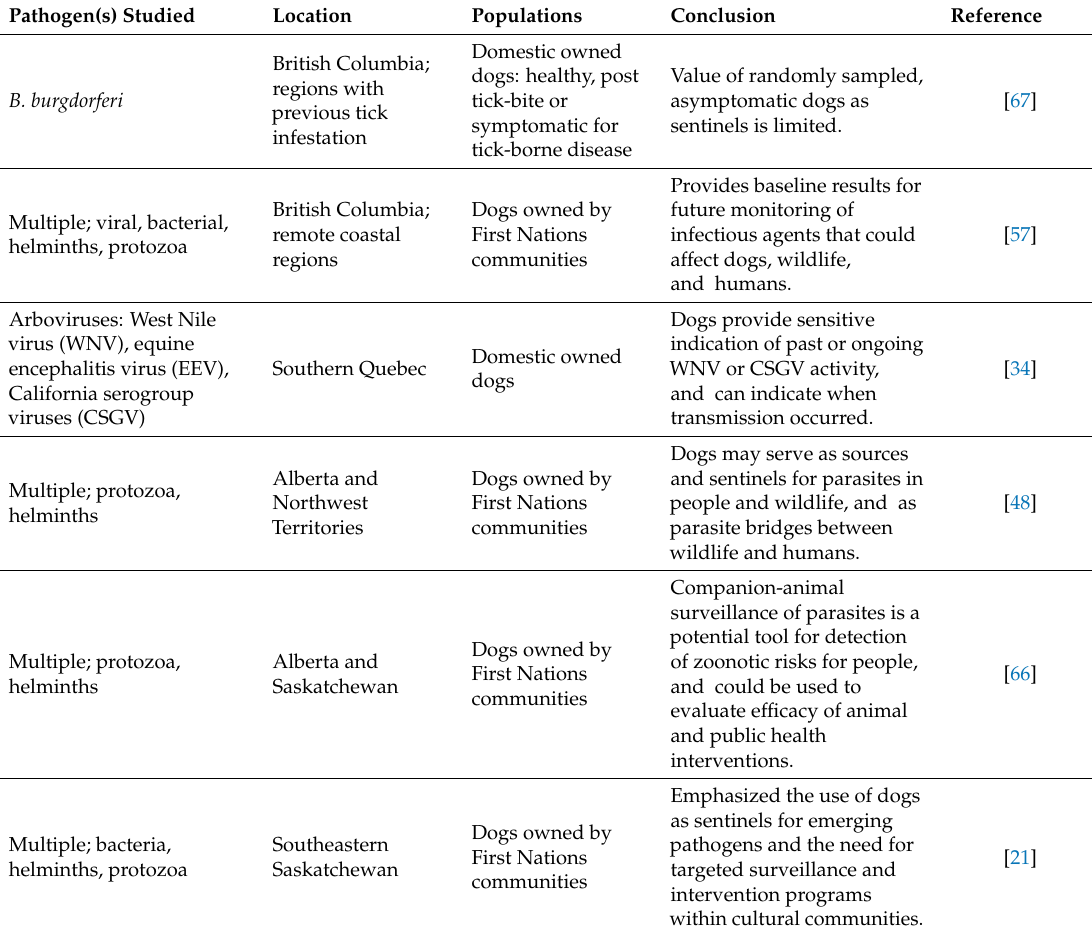
Table 2. Results with data originating from